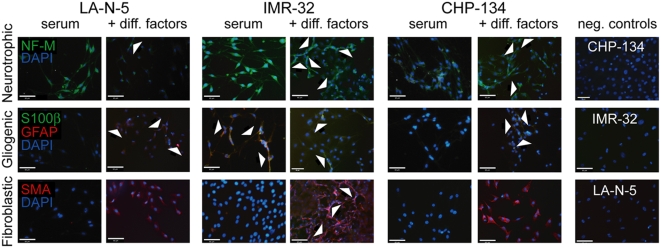
Clonally-derived neuroblastoma tumorsphere cells show multi-lineage differentiation.Clonally-derived tumorspheres from three different neuroblastoma cell lines were dissociated and cells were plated on poly-lysine and laminin coated chamber slides. Culture conditions were media containing serum alone or serum with neurotrophic factors (top row), gliogenic factors (middle row) or fibroblastic factors (bottom row) (except negative controls, which were serum alone without factors). Slides were stained with neurofilament-M (NF-M, green, top row), GFAP (red, middle row) S100β (green, middle row), or smooth muscle actin (red, bottom row); each were also co-stained with DAPI (blue). Negative control cultures were incubated without primary antibody and with secondary anti-mouse TRITC or anti-rabbit FITC. Arrows in the top and bottom rows indicate spindle-like cell extensions consistent with either neuronal or fibroblastic differentiation, while arrows in the middle row indicate positively stained cells. On close inspection of the GFAP/S100β stains, IMR-32 cells under serum conditions and CHP-134 cells supplemented with factors show co-staining with a mixture of green/red signals. Scale bars = 65 microns.